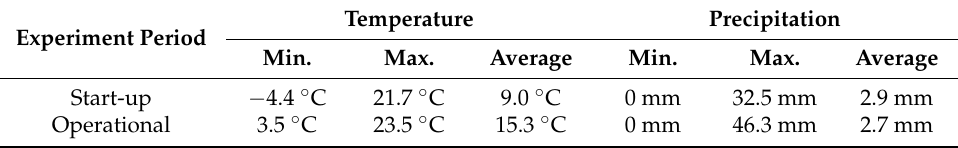
Figure 5. Changes in temperature and precipitation at the Amherstview WPCP over the entire experimental period. Table 5. Summary of temperature and precipitation data during the entire experimental period. Experiment